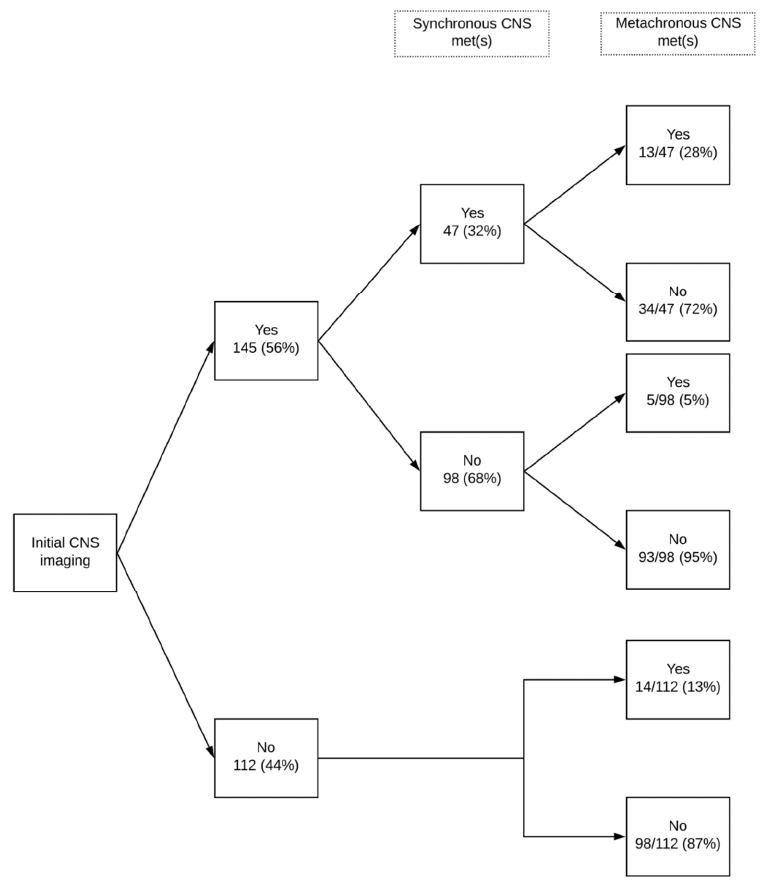
Figure 2. Synchronous and metachronous CNS metastases. CNS = central nervous system; met = metastasis.